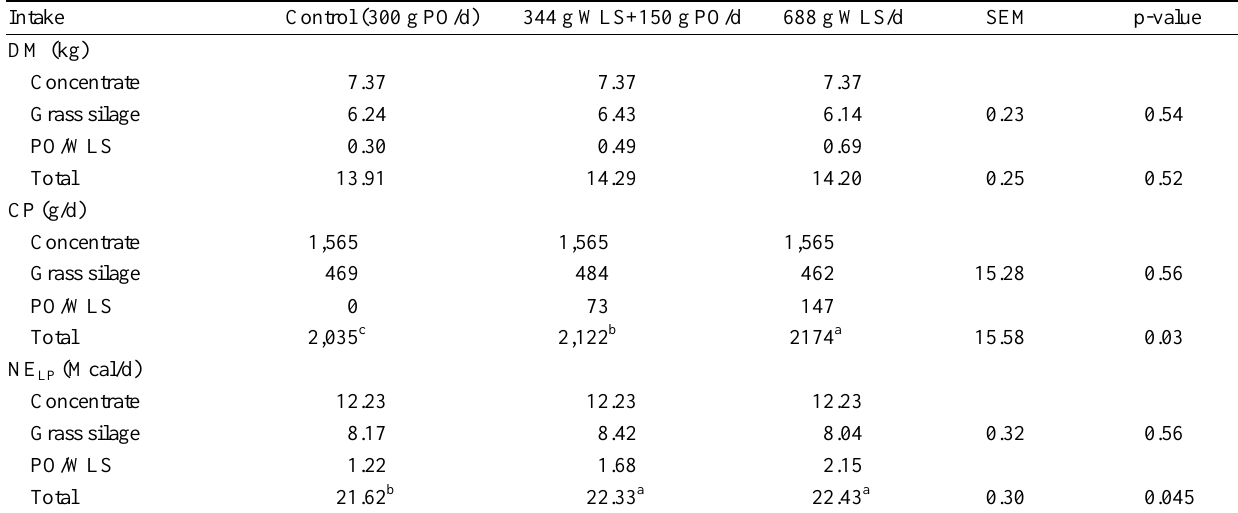
Table 3. Effects of whole linseed supplementation on DM, CP and NE LP intakes of dairy cows